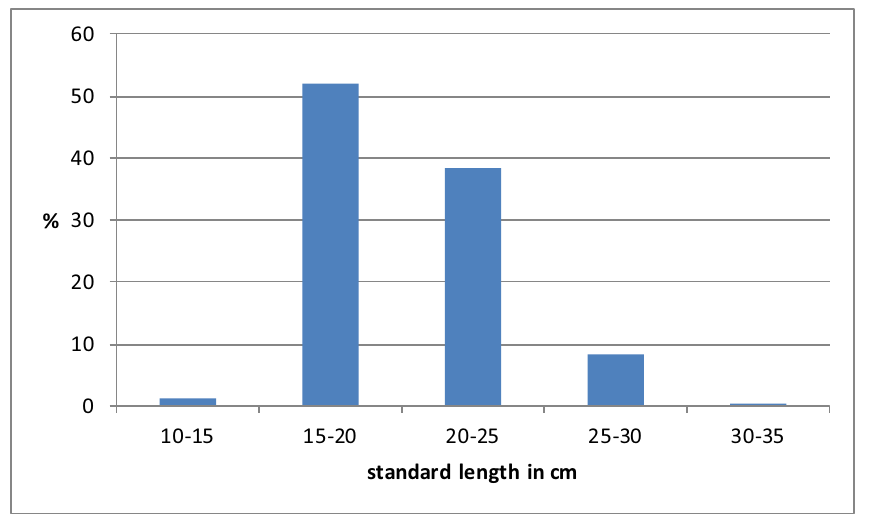
Fig 8. The reconstructed fish lengths of the tilapia, presented in 5 cm size classes. Total sample size was 2541 specimens.